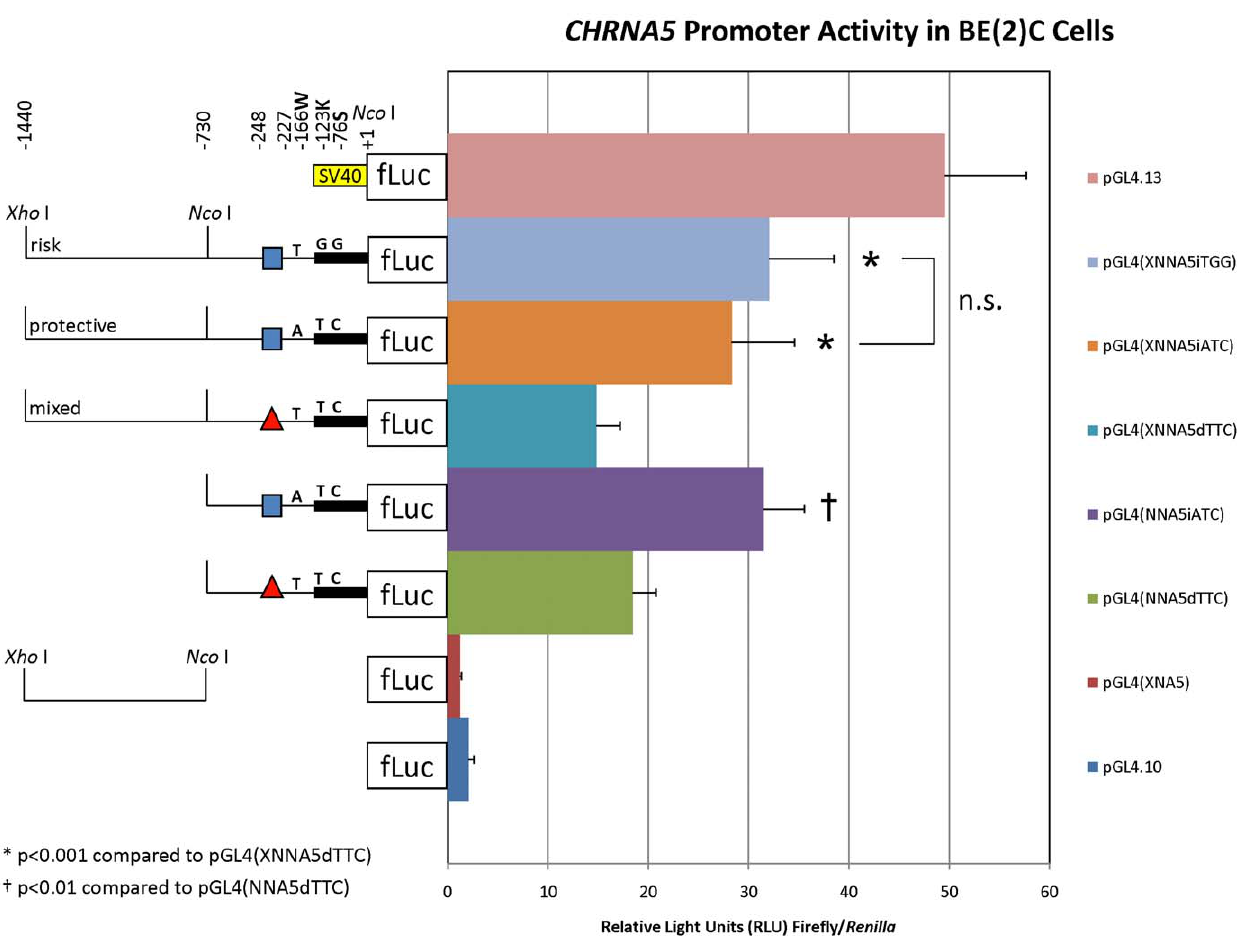
Figure 2. Relative CHRNA5 promoter activity in BE(2)-C cells. Shown are the averages 6 standard deviations of five separate transfections each done in triplicate. The SV40 promoter of the positive control vector pGL4.13[luc2/SV40] is indicated by a yellow box. The ‘‘promoterless’’ negative (background) control vector pGL4.10[luc2] is shown without a promoter region in front of the firefly luciferase (‘‘fLuc’’) reporter gene. For experimental CHRNA5 promoter-5 9 UTR constructs, thin and thick black lines represent the promoter and 5 9 UTR portion of the construct, respectively. Positions of the Xho I ( 2 1440) and Nco I ( + 1) sites used for subcloning are indicated, as is an internal Nco I site ( 2 730). The positions and identities of the rs3841324 ( 2 227 to 2 248), rs503464 ( 2 166W), rs55853698 ( 2 123K) and rs55781567 ( 2 76S) polymorphisms within each construct are indicated. The deletion (‘‘d’’ in construct name) or normal (‘‘i’’ in construct name) allele at rs3841324 is indicated by a red triangle or blue square, respectively. The deletion (‘‘d’’) constructs exhibited decreased activity (1.6–2.0-fold) relative to the normal (‘‘i’’) constructs. *p , 0.001 compared to pGL4(XNNA5dTTC); { p , 0.01 compared to pGL4(NNA5dTTC) by ANOVA with Tukey’s post-hoc analysis. ‘‘n.s.’’ indicates not significant.